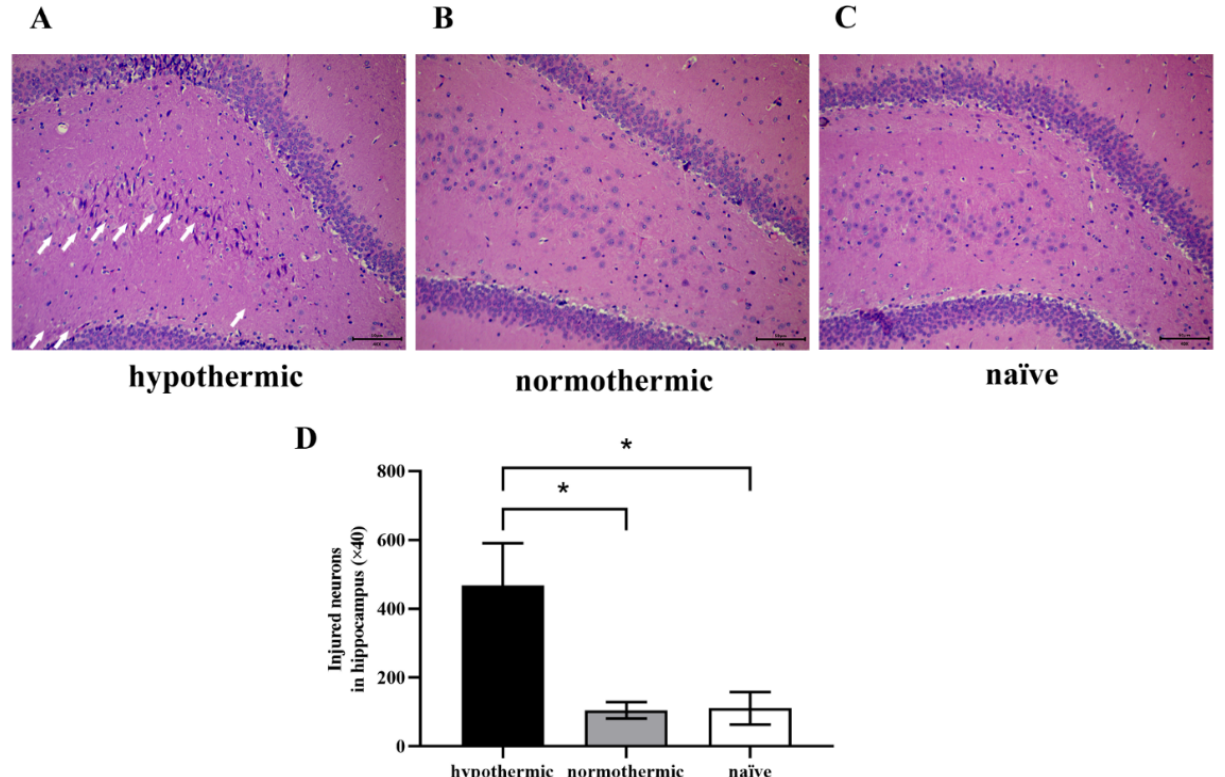
Figure 4. Morphological changes of hippocampal neurons in rats among groups were observed under bright-field illumination using a fluorescence microscopy imaging system. ( A – C ) Representative images of HE staining in hippocampal slices; ( D ) quantitative analysis of injured neurons with neuronal pyknosis and necrosis in the hippocampal DG region. The white arrow indicates a disorderly nucleus, neuronal pyknosis and necrosis. Magnification: × 40; scale bar: 50 µ m. Data are expressed as mean ± SEM. * p < 0.05, n = 4.